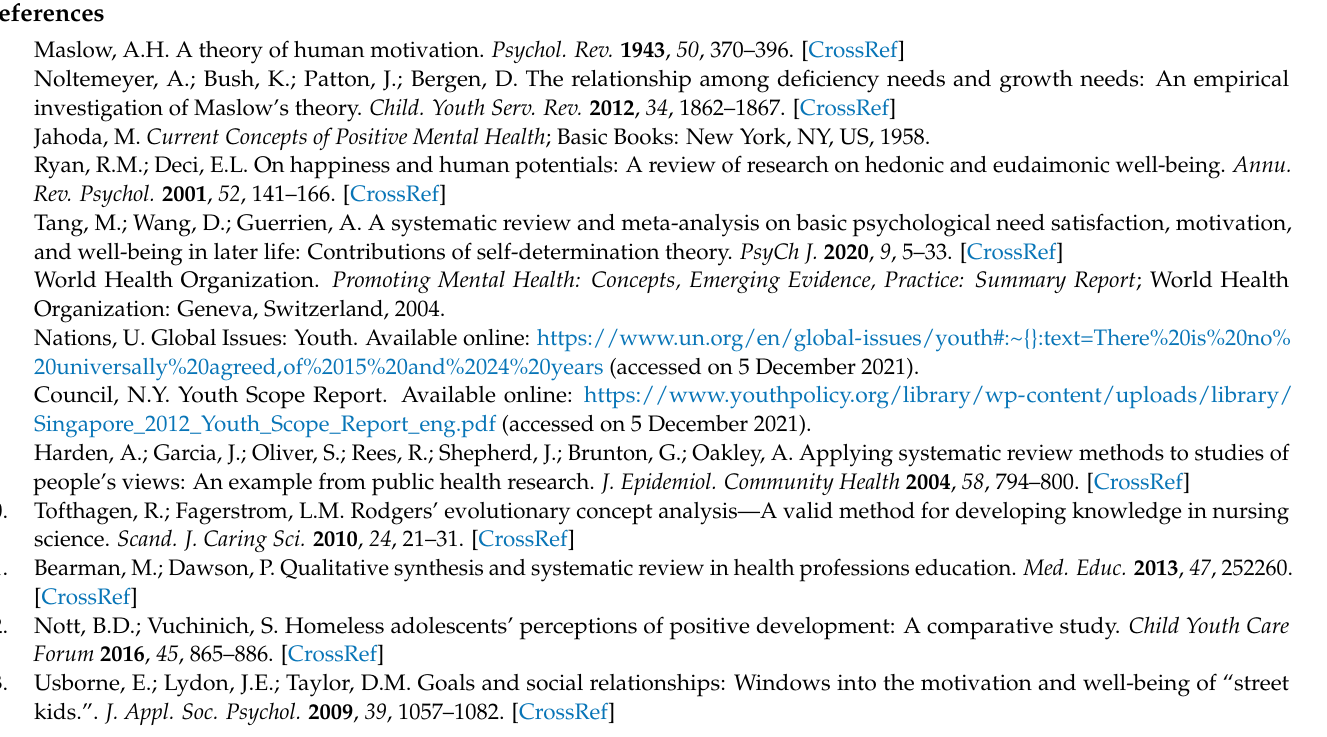
Table S2: Characteristics of included studies ( n = 105). References [12–14,17–97,101–118,120,121,132] cited in Supplementary